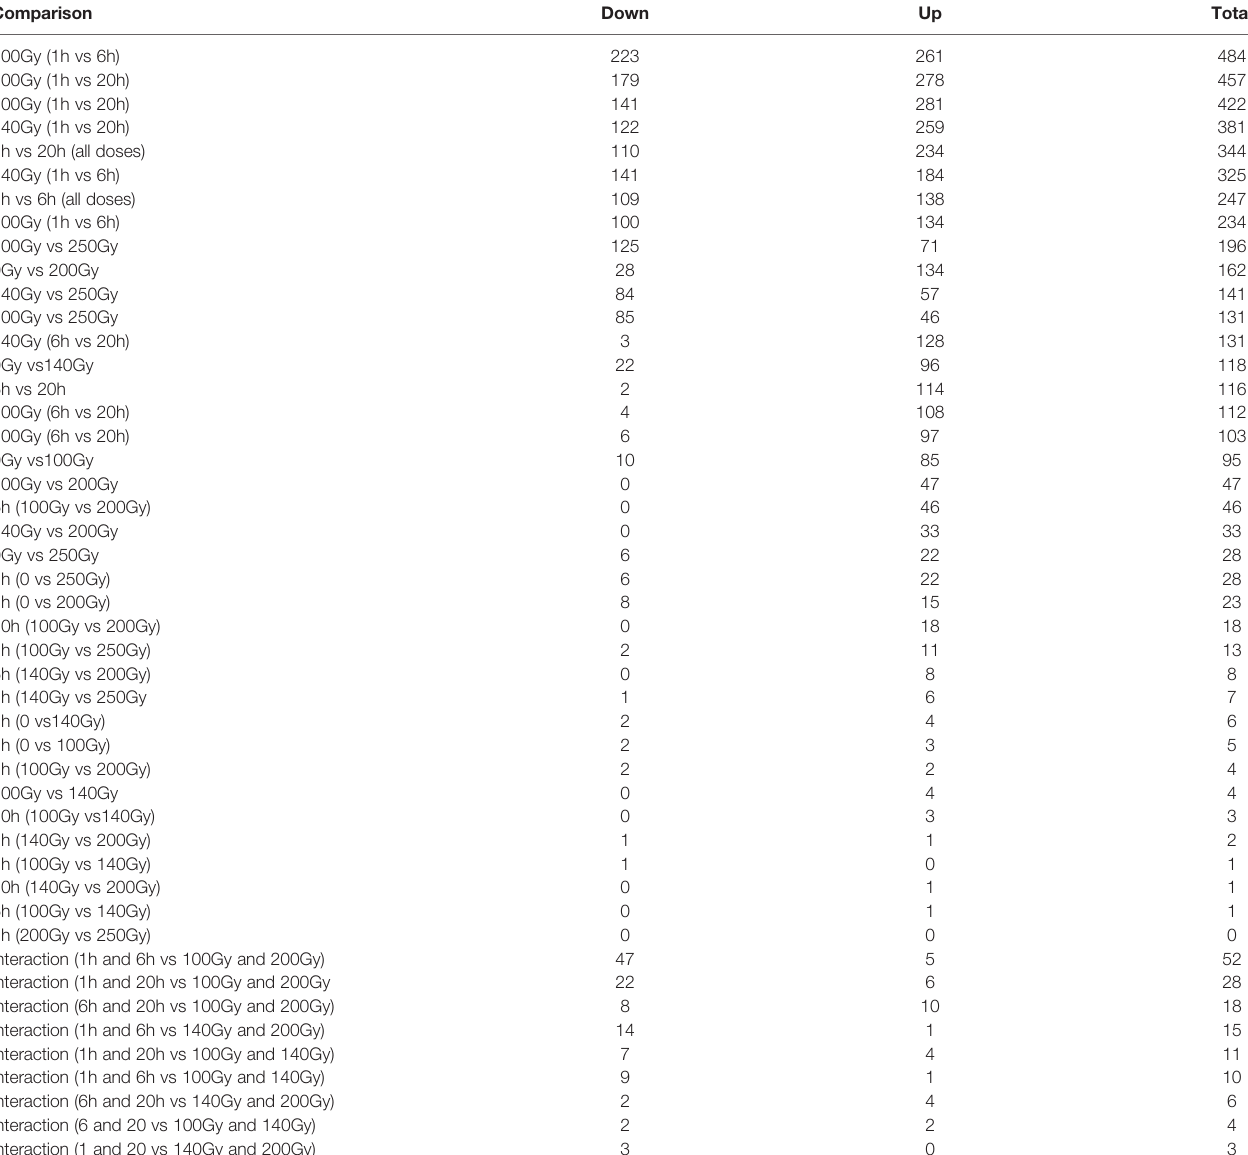
TABLE 1 | A comparison of gene transcripts across different doses and time. Comparison